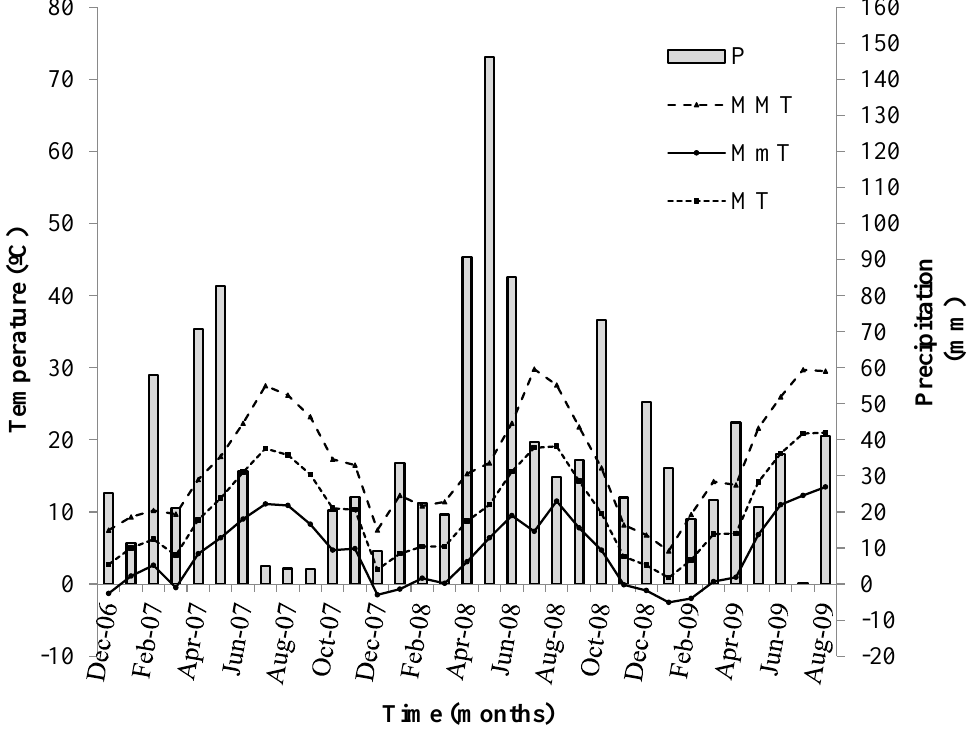
Figure 1. Meteorological conditions during the decay assay. Notes: P: Precipitation, MMT: Mean maximum temperature, MmT: Mean minimum temperature, MT: Mean temperature.